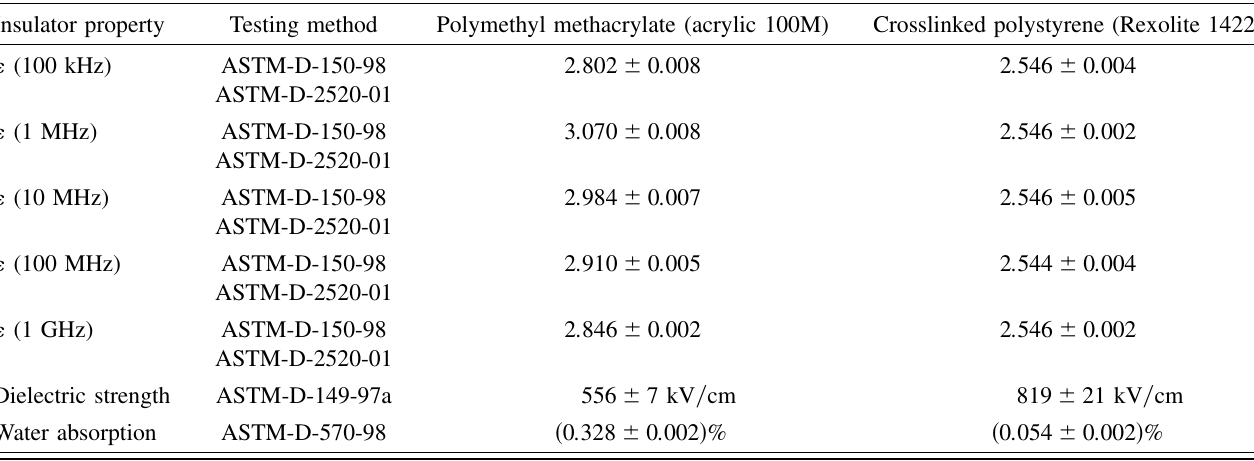
TABLE I. Measured values of the dielectric constant " , dielectric strength, and water absorption of polymethyl methacrylate (acrylic 100M) and crosslinked polystyrene (Rexolite 1422). The measurements were performed at room temperature. Each set of measurements was performed on 5 samples; the uncertainty given is the standard deviation of the mean due to random fluctuations [49]. The dielectric-strength measurements were performed under oil (to prevent flashover) on samples that were nominally 0.29 mm thick. The voltage applied was at 60 Hz, and was increased on each sample at 500 V (rms) per second until breakdown occurred. The breakdown fields reported in the table are rms values.